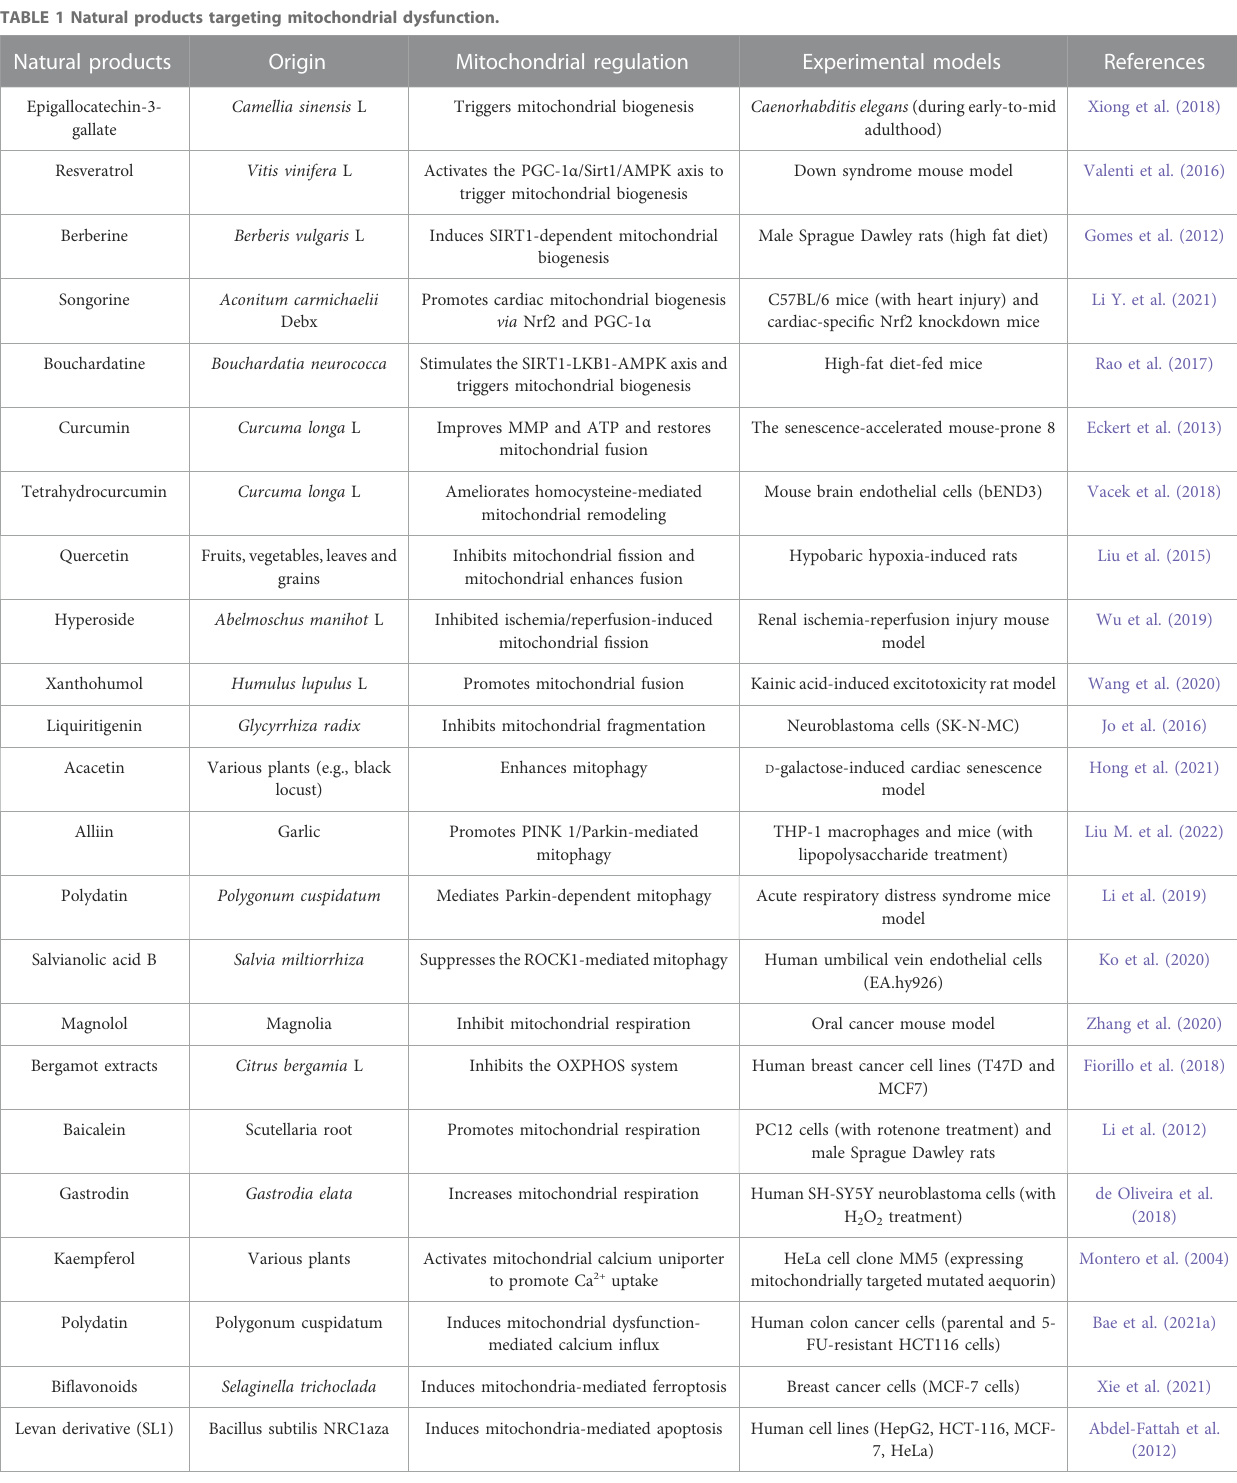
TABLE 1 Natural products targeting mitochondrial